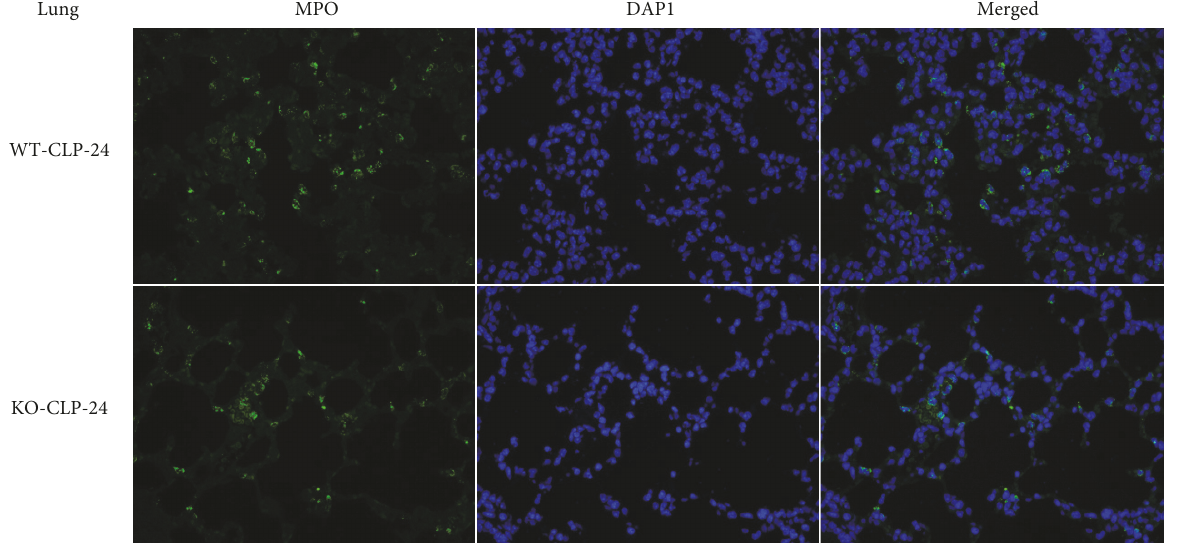
Figure 11: Lack of 5-HT decreases the level of MPO in the lung in CLP-induced sepsis. MPO staining of the lung tissue at 24 h after CLP administration. The MPO-stained cells (green), the corresponding nuclear counterstaining (blue), and both channels merged display the relative change in the level of MPO observed in a typical fi eld. The MPO staining was signi fi cantly decreased in the KO-CLP sepsis group compared to the WT-CLP sepsis group in the lung at 24h after CLP. Original magni fi cations, ×